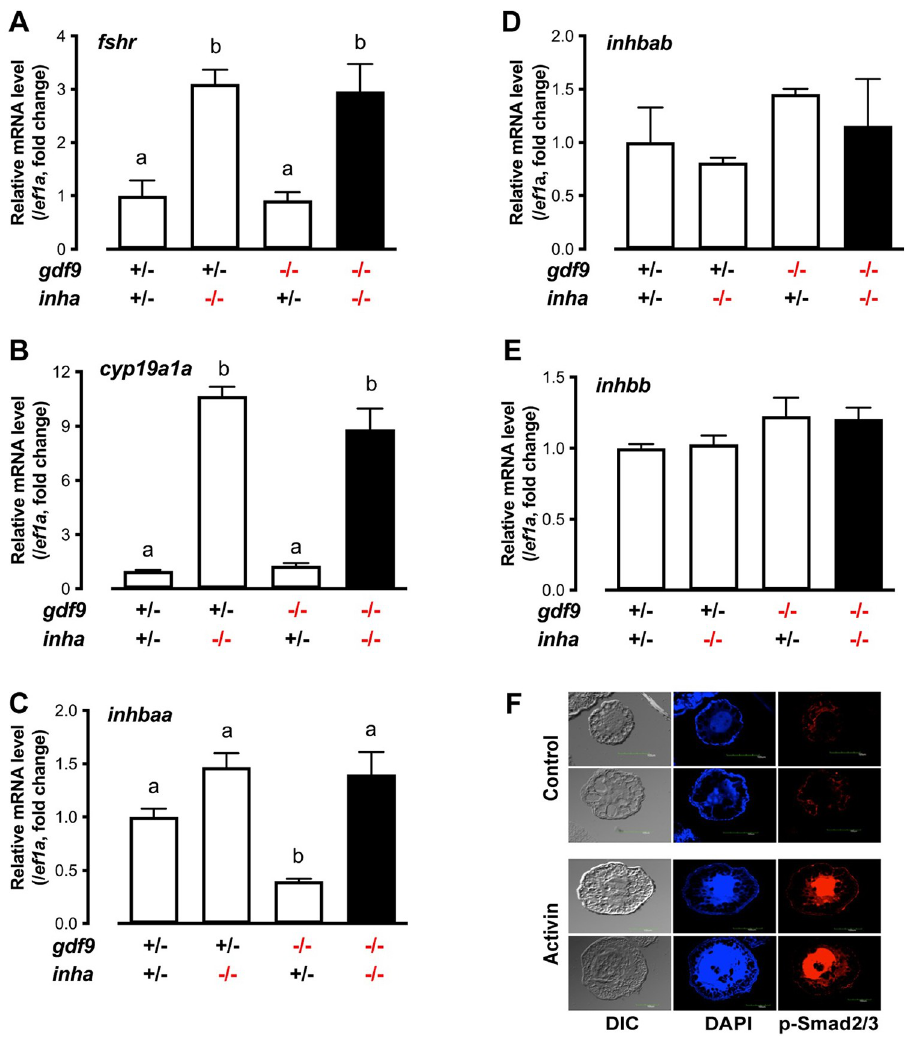
Fig 9. Expression of fshr , cyp19a1a and activins ( inhbaa , inhbab and inhbb ) in PG follicles from single ( gdf9-/- and inha-/- ) and double mutant ( gdf9-/-;inha-/- ). (A-E) The PG follicles were isolated from the fish of different genotypes at 43 dpf, shortly before puberty onset or PG-PV transition occurs in the control fish (normally around 45 dpf). The expression of inhbaa was significantly reduced in gdf9-/- mutant; however, it was reversed by inha mutation in the double mutant together with fshr and cyp19a1a , but not inhbab and inhbb . Different letters indicate statistical significance (P < 0.05, n = 3 biological replicates). (F) Stimulation of Smad2/3 phosphorylation (p-Smad2/3) in the PV oocytes by activin in vitro. The PV follicles were isolated and treated with recombinant goldfish activin B (5 U/ml) for 2 h followed by immunofluorescent staining for p-Smad2/3.